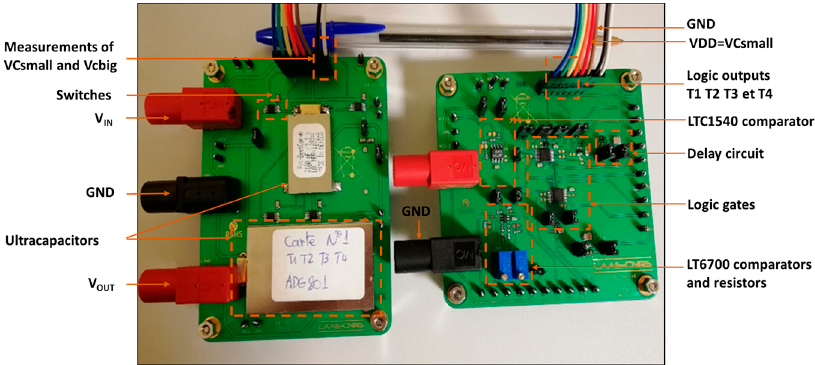
Figure 8. Prototype of the proposed variable storage architecture.